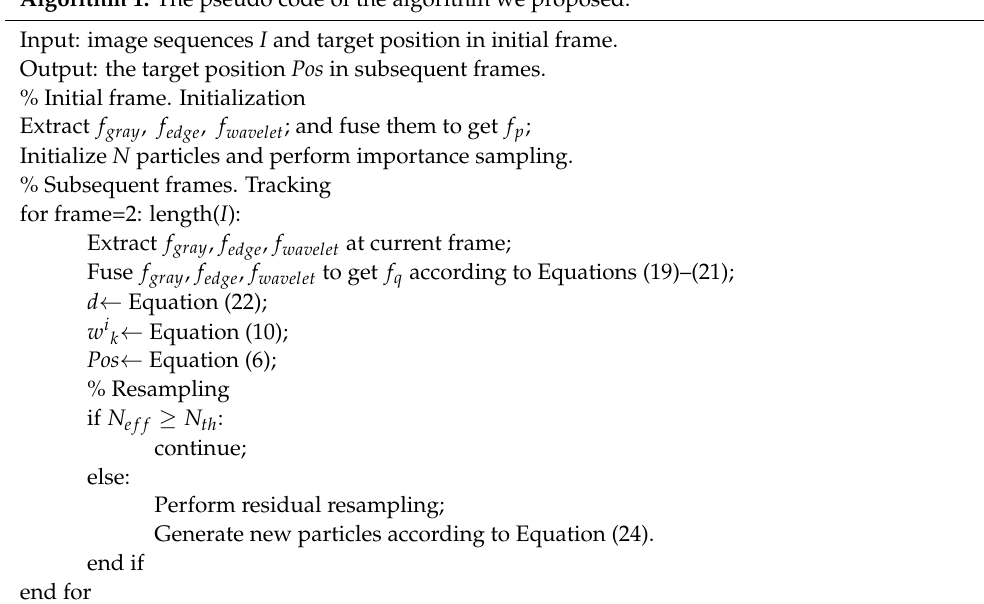
Algorithm 1. The pseudo code of the algorithm we